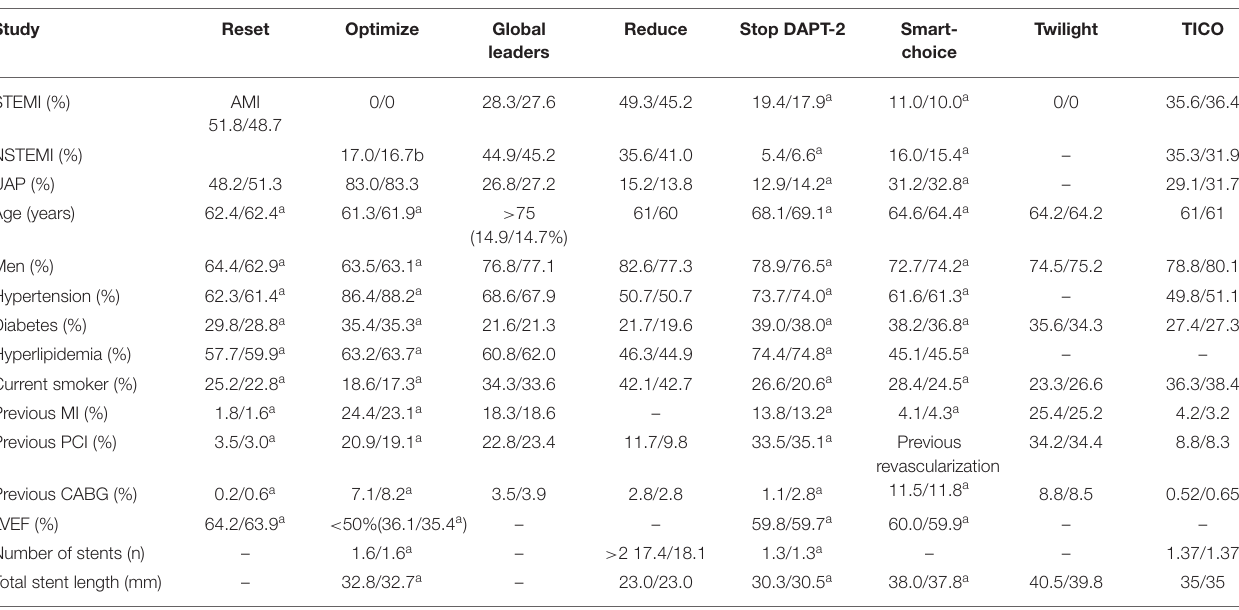
TABLE 2 | Baseline characteristics of the patients